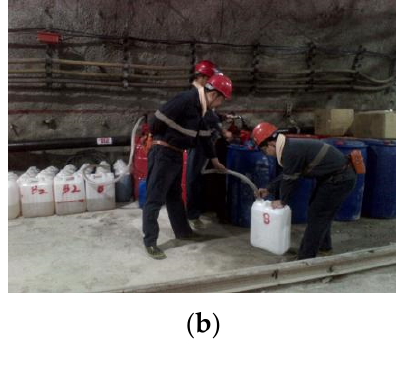
( d ) Figure 5. Laboratory grouting model experiment and actual grouting process underground. ( a ) La- boratory grouting model. ( b ) Actual underground grouting batching. ( c ) Carrying out underground grouting. ( d ) Grouting orifice. 4. Conclusions In this study, PC and GBFS alkali-activated grouting materials were prepared with different mix proportions. XRF was carried out to determine the content and reactivity of various elements in PC and GBFS. The influence of different proportions on the develop- ment of compressive strength and condensation behavior was analyzed. The effects of sodium hydroxide and LSS on the formation of mineral crystals in both PC and GBFS alkali-activated specimens were further analyzed using XRD. The microstructure and morphological characteristics were analyzed by SEM.